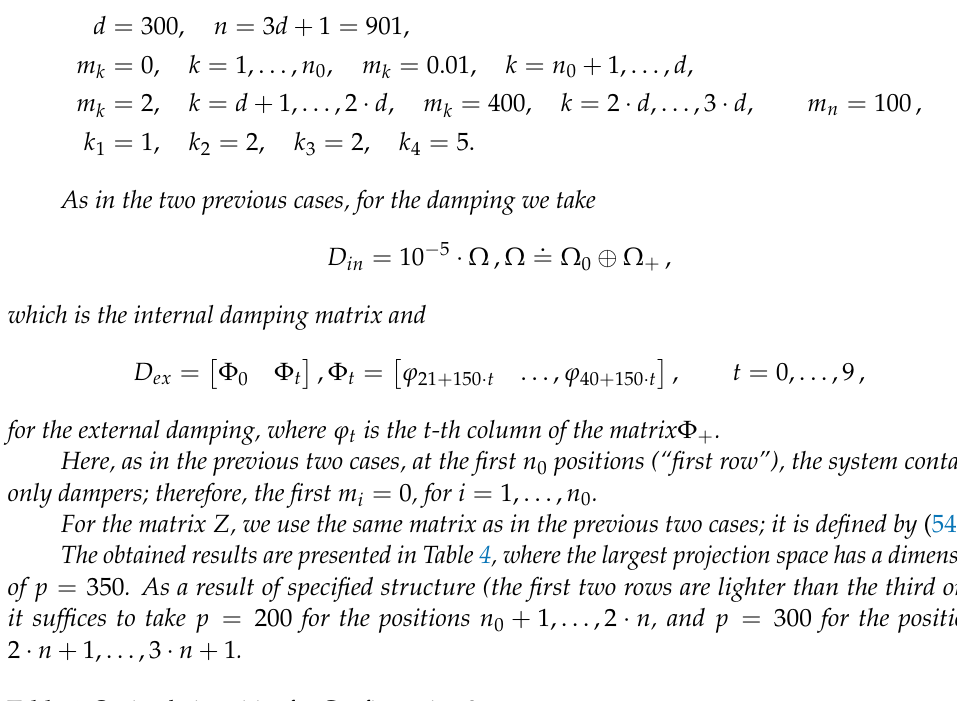
Table 4. Optimal viscosities for Configuration